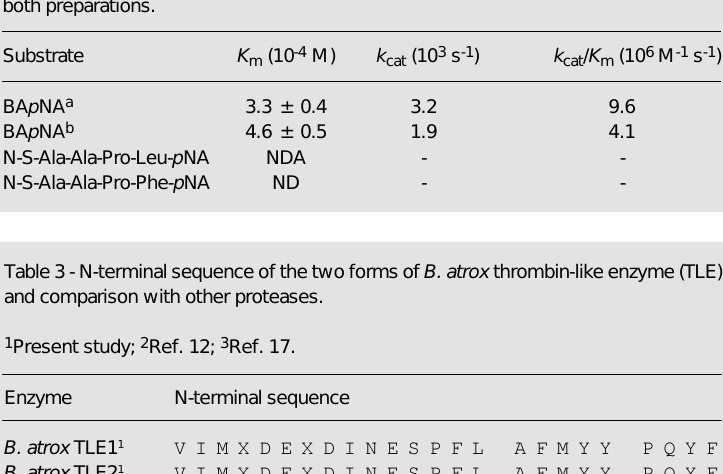
Table 2 - Kinetic parameters for the thrombin-like enzyme (TLE)-catalyzed hydrolysis of peptide chromogenic substrates. a For TLE1; b for TLE2. NDA, Non-detectable activity under the experimental conditions for both preparations (TLE1 and TLE2). ND, Not determined (superior to 25 mM) for both preparations.